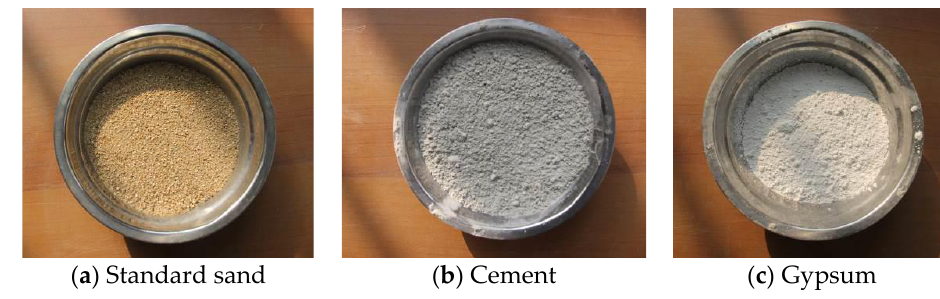
Figure 5. The strength testing of the samples.